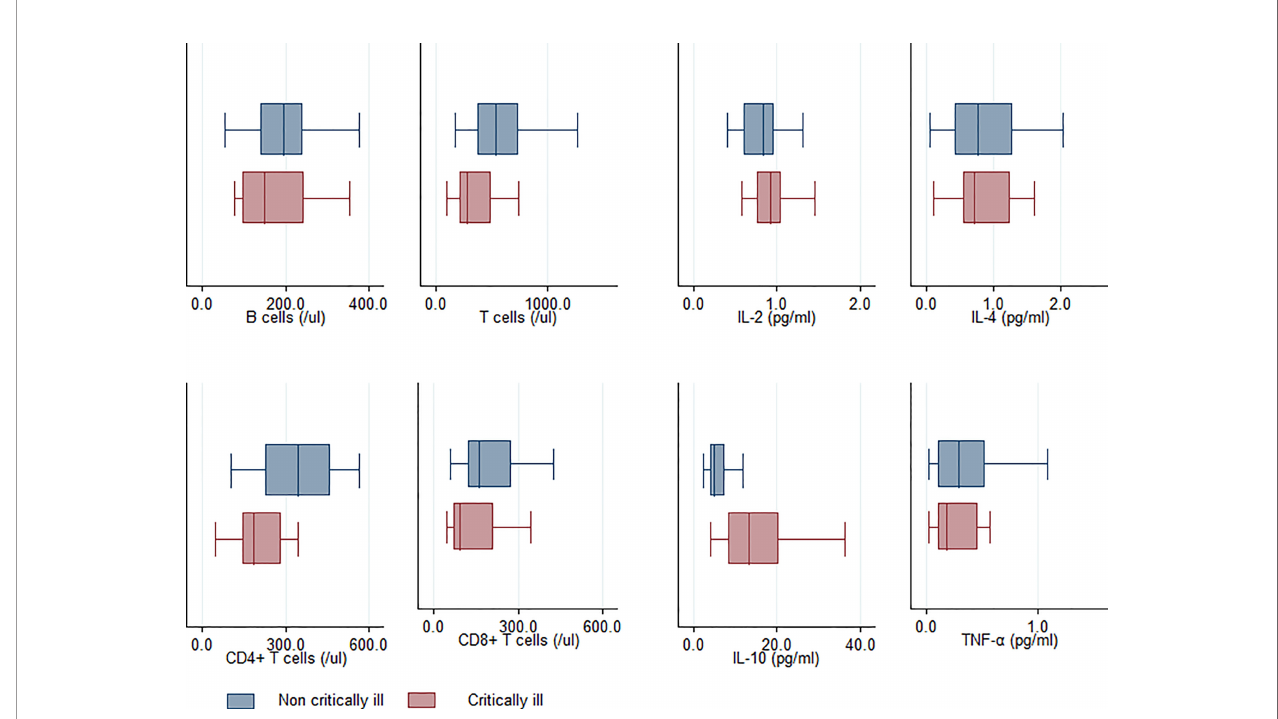
FIGURE 1 | Comparison of cytokine pro fi le and immune cells between critically and non-critically ill patients exhibiting COVID-19 pneumonia.